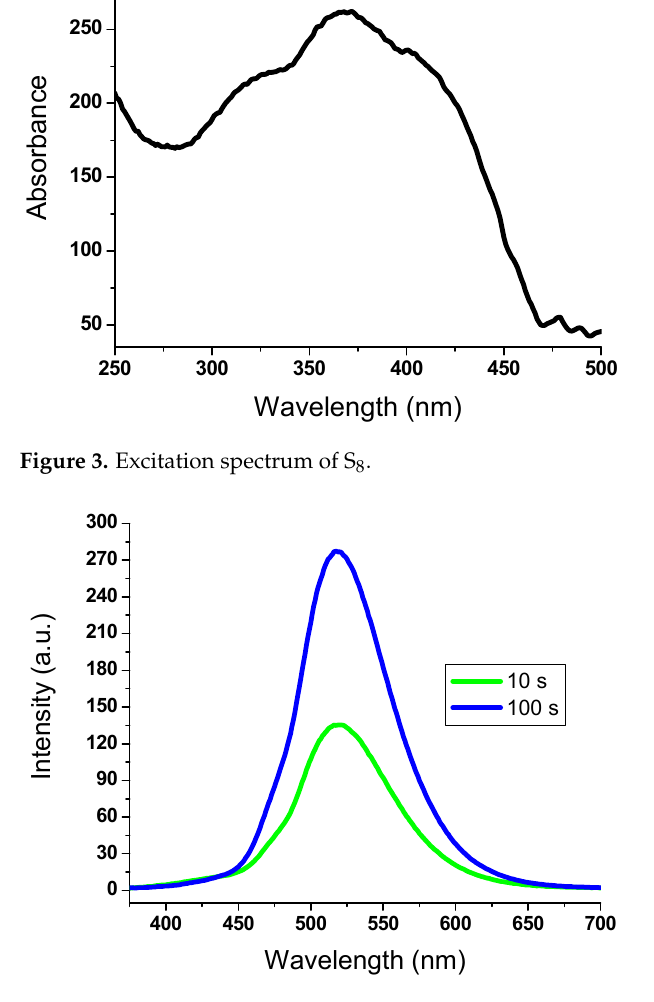
Figure 4. Phosphorescence emission spectra of S 8 after 10 s and 100 s of UV irradiation.